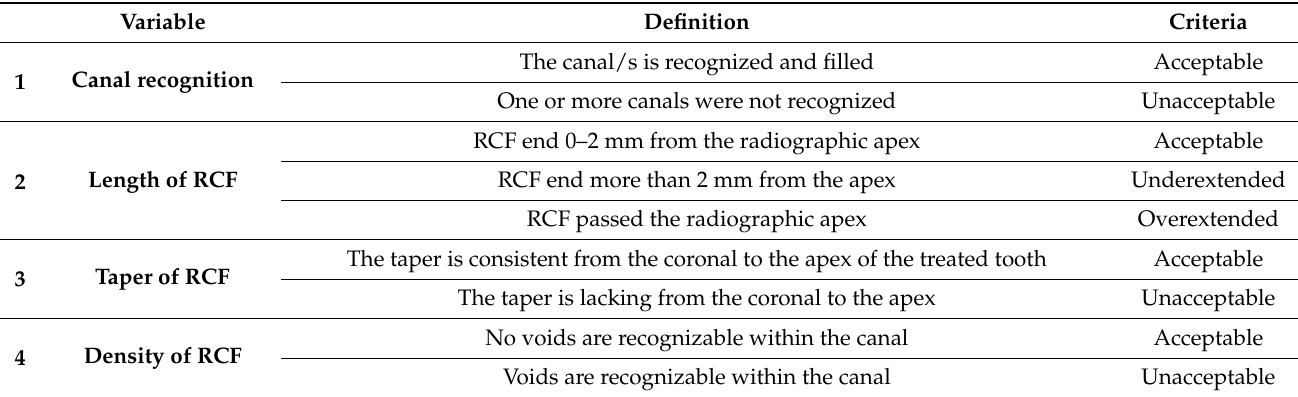
Table 2. Criteria of calibration of performed root canal